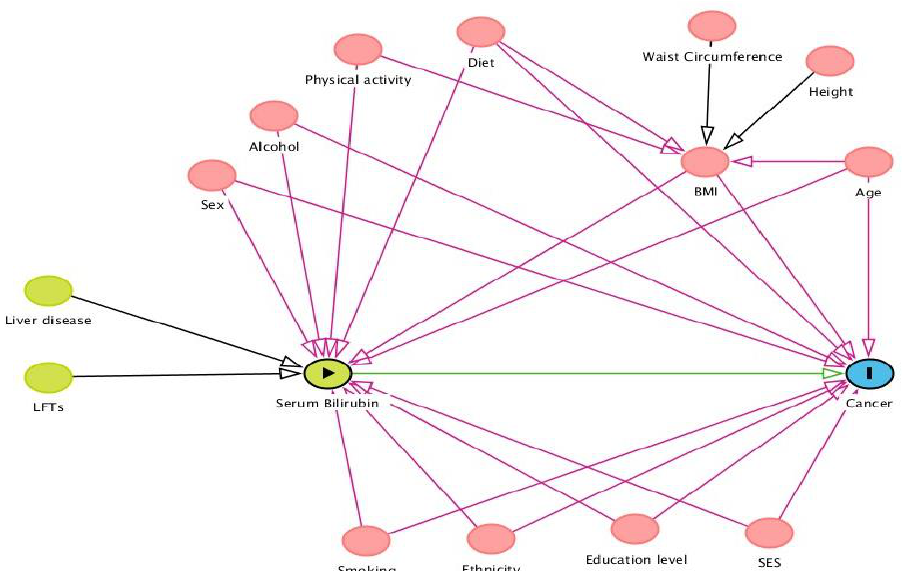
Figure 2. Directed acyclic graph to assess relationships between potential confounders. BMI, body mass index; SES, socioeconomic status; LFTs, liver function tests. Serum bilirubin is the exposure of interest, whilst cancer is the outcome. The other variables are hypothesized confounders of the association between exposure and outcome. The green arrow illustrates the exposure-outcome relationship; pink arrows illustrate the confounder-exposure and confounder-outcome relationships; black arrows illustrate associations between variables with no confounding effect; blue arrows illustrate potential effect modifiers between exposure and outcome.